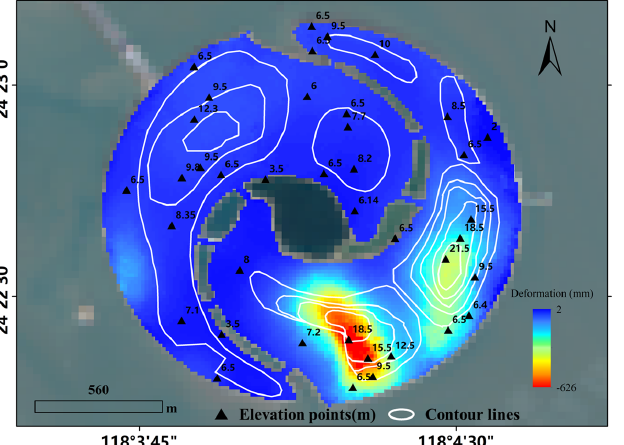
Figure 15. Deformation time series in the vertical direction at two points P5 ( a ) and P6 ( b ) of Xiamen Xiang’an Airport, whose positions are marked in Figure 6.